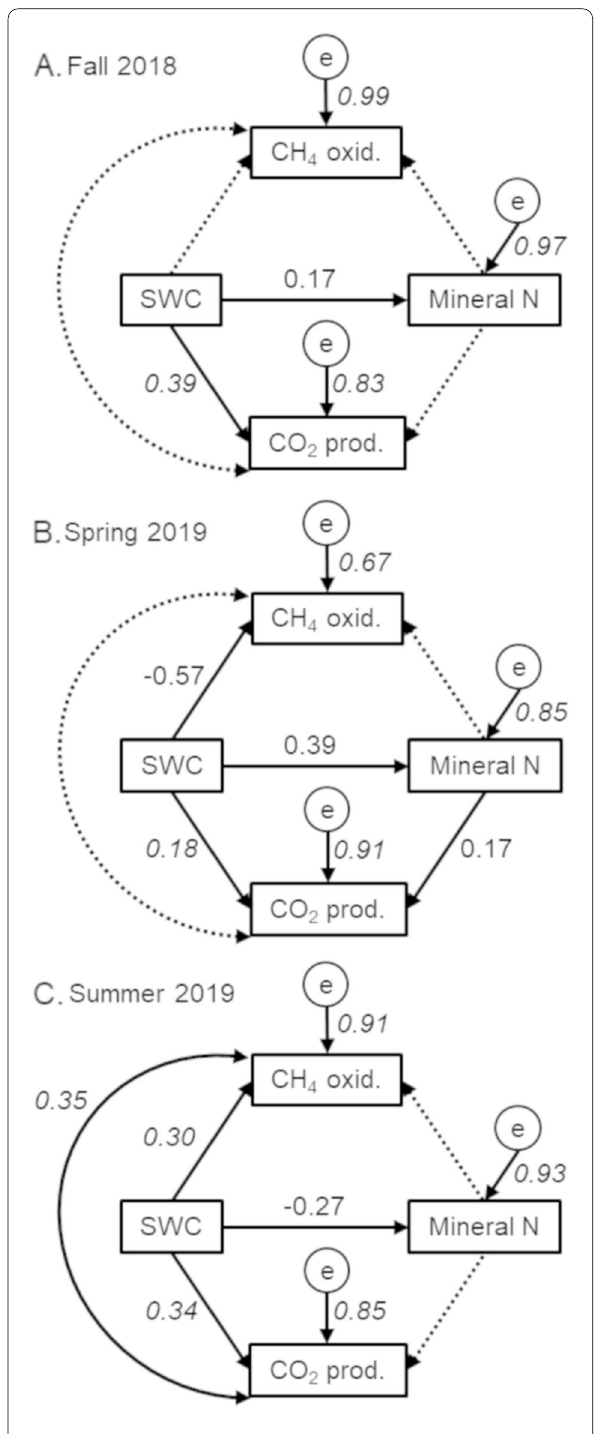
Fig. 5 Structural equation model analysis showing the direct influence of soil water content (SWC) and soil mineral nitrogen on potential CH 4 oxidation and CO 2 production in the top soil layer (intact soil cores), and the covariation of these two processes, in A fall 2018 ( χ 2 0.011, p 0.917; cfi 1.000; rmsea 0.000; srmr = = = = 0.003), B spring 2019 ( χ 2 0.000, p 0.998; cfi 1.000; rmsea = = = = 0.000; srmr 0.000) and C summer 2019 ( χ 2 0.962, p 0.327; = = = = cfi 1.000; rmsea 0.000; srmr 0.031). Solid straight arrows = = = represent significant pathways ( p < 0.05), and dotted arrows indicate nonsignificant pathways. Numbers adjacent to the arrows are standardised path coefficients (shown only for significant paths). The curved double-sided arrows represent the covariation between CH 4 oxidation and CO 2 production. e is the variance that is not explained by the predictors. Numbers of observations are 156 (12 samples in 13 stands) in A and B and 96 in C (12 samples in 8